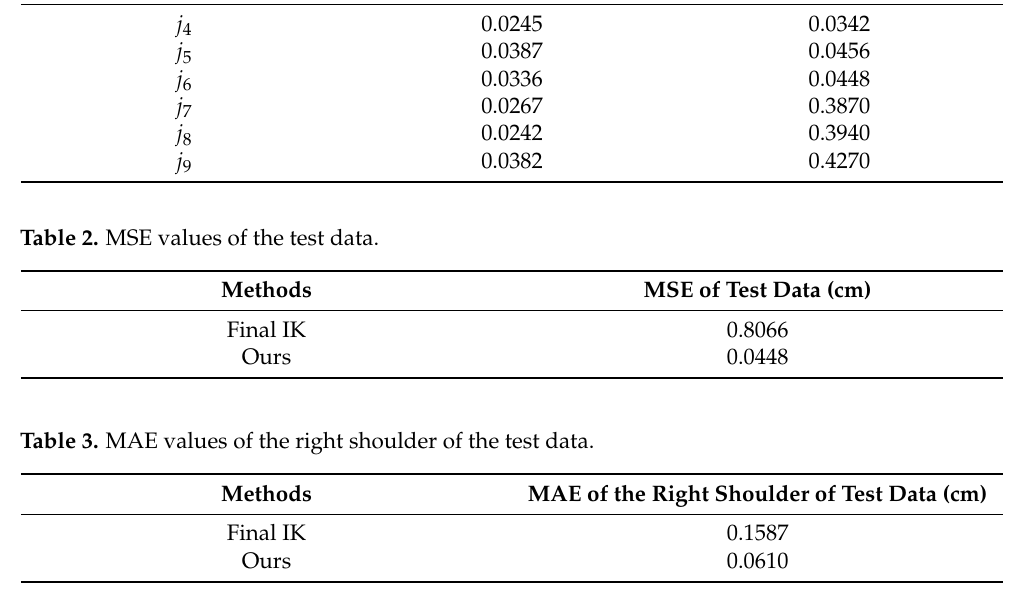
Figure 5. Mean absolute error(MAE) of the predicted values and the ground truth data of the right shoulder or joint j 7 of the last (5th) epoch. Table 1. MSE values for j 4 , j 5 , j 6 , j 7 , j 8 , and j 9 . Joints